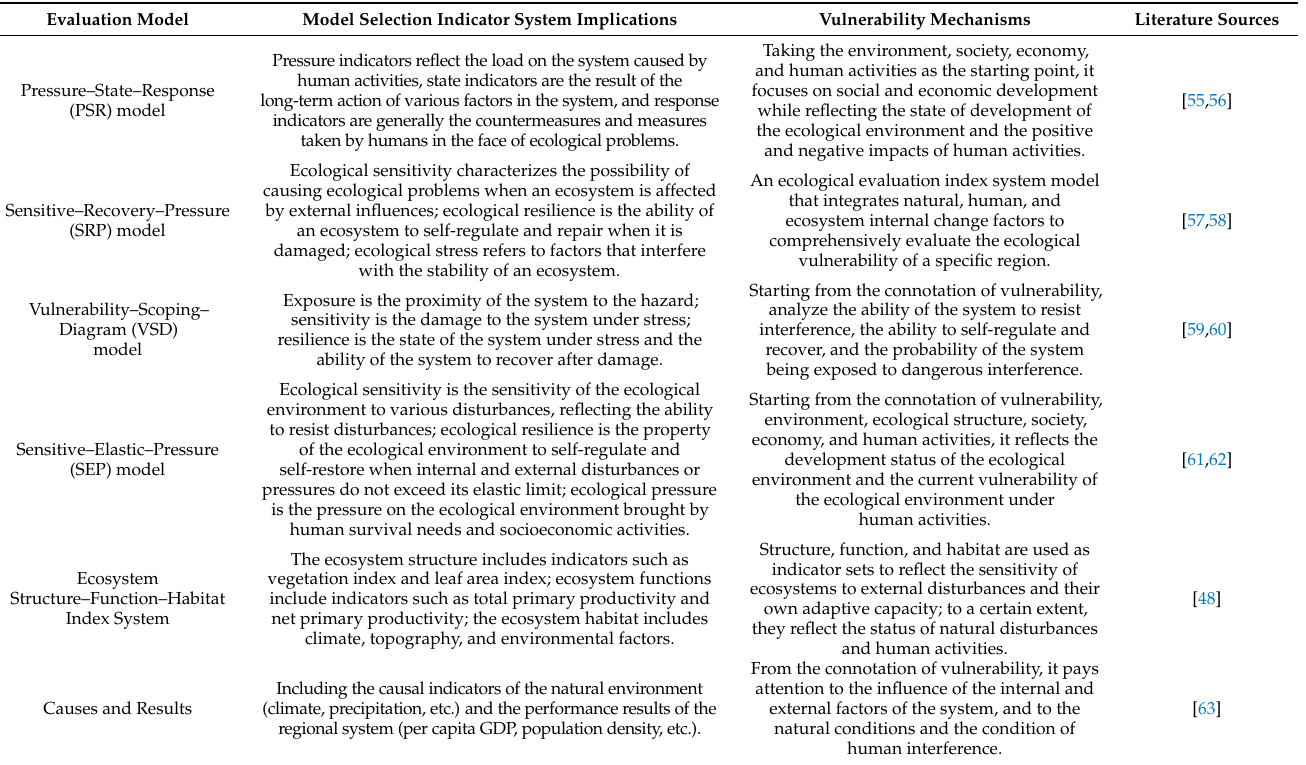
Table 3. Ecological vulnerability evaluation